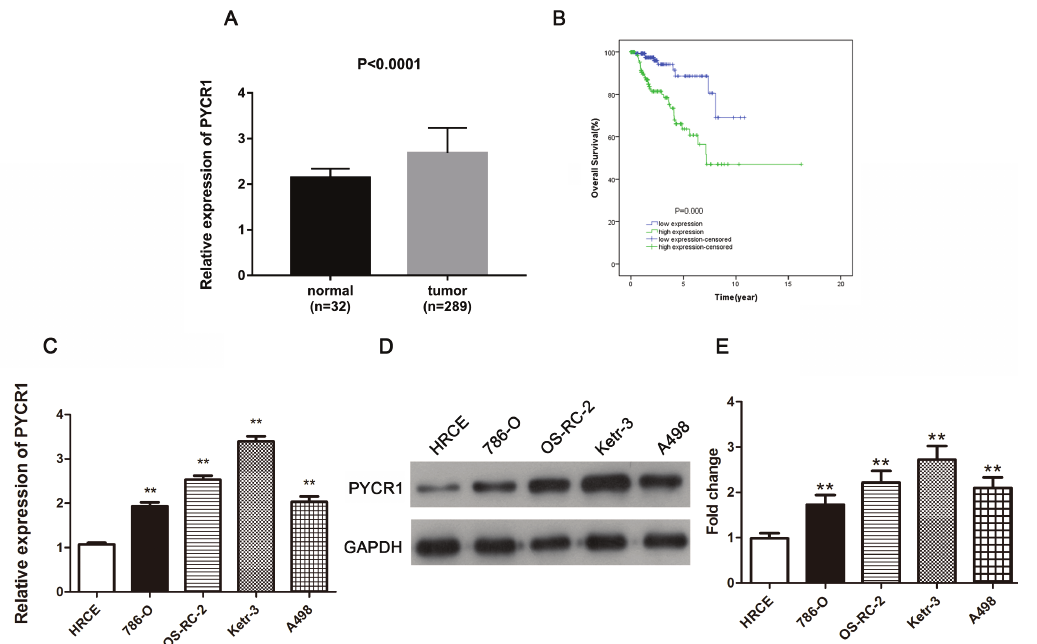
Figure 1: PYCR1 is promoted in PRCC tissues and cells, meanwhile up-regulated PYCR1 is related to poor prognosis in PRCC patients. (A) The relative expression of PYCR1 in PRCC tissues compared to normal tissues. (B) The overall survival curve in PRCC patients with high and low expression of PYCR1. (C) and (D) Comparison of PYCR1 expression in diverse cell lines through qRT-PCR and western blot analyses. (E) The quantification of protein expression level. All the data are expressed as mean ± SD and each test was performed in three times. (**P < 0.01). Supplement Figure 1: The correlation between PYCR2/PYCR3 expression and PYCR1 expression or survival rates of PRCC patients. (A) PYCR2 was over expressed in PRCC tissues consisting of 32 normal cases and 289 PRCC cases. (B) Survival curve showed the connection between PYCR2 expression and PRCC. (C) PYCR3 was increased in PRCC tissues including 32 normal cases and 289 PRCC cases. (D) The survival curves analysis on the basis of PYCR3 expression. (E) and (F) PYCR1 expression was closely linked with PYCR2/PYCR3 by the Pearson’s analyses.